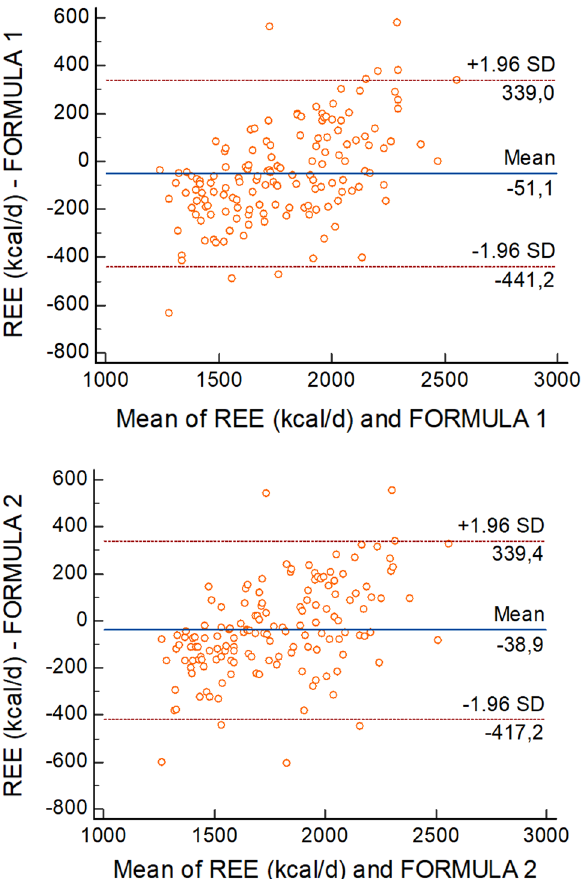
Figure 1. Agreement between measured and predicted resting energy expenditure (REE) using the Eqs. (1) and (2)—Bland Altman